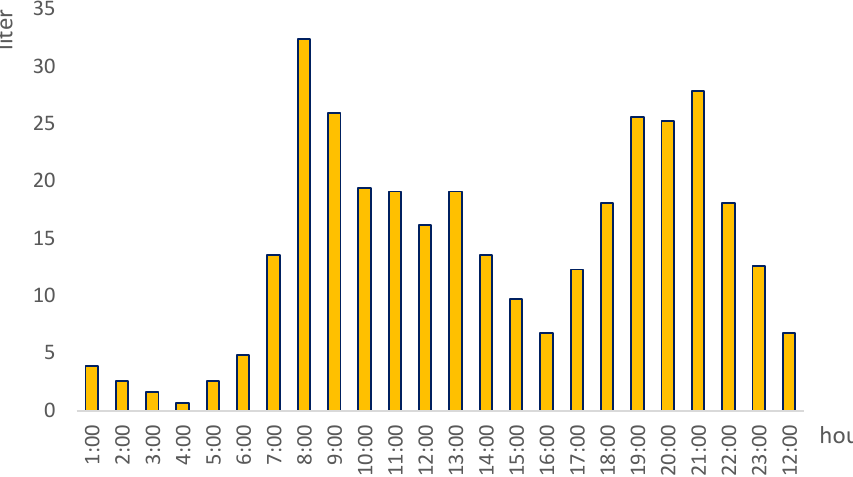
Figure 12. The DHW consumption of a sample household in Building A. Table 9. The characteristics of the boiler in district heating system.